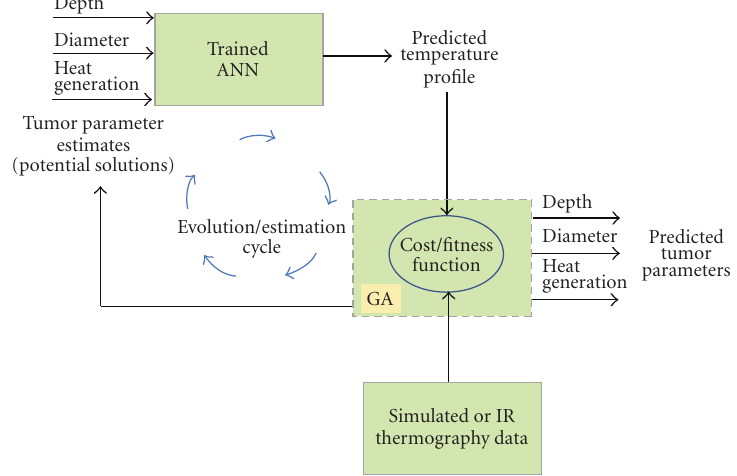
Figure 1: Overall estimation methodology for prediction of breast tumor parameters.